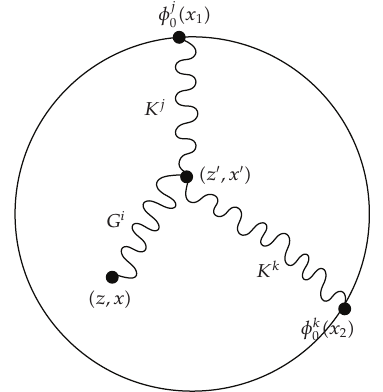
Figure 15: Witten diagram 2, created by Daniel